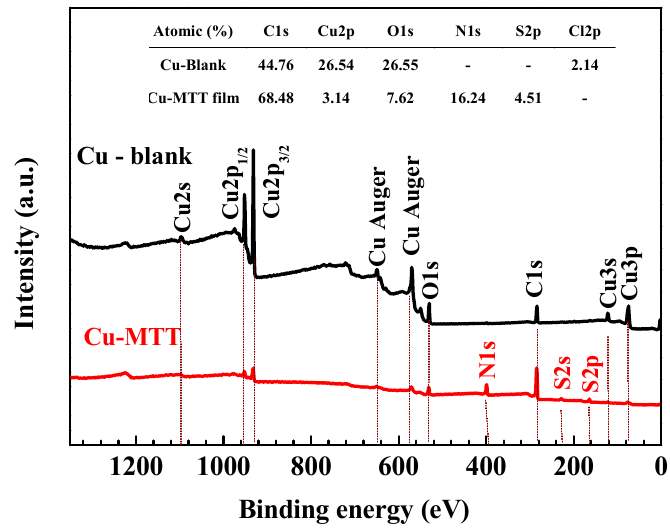
Figure 8. Representative XPS survey spectra for the blank and Cu-MTT film. Table 3. The homologous binding energy, chemical states and FWHM XPS spectra peaks from the surface of the blank and Cu-MTT film, respectively.